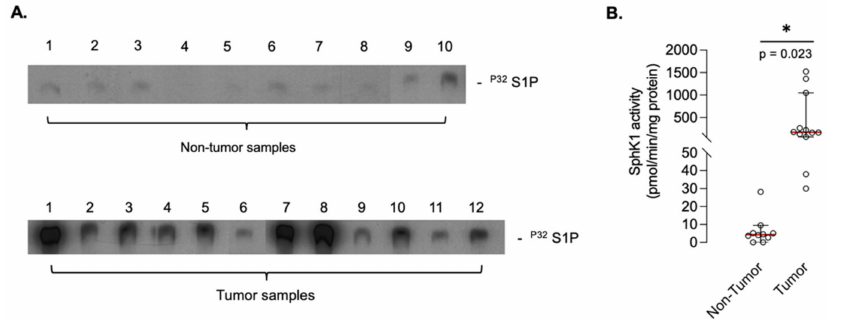
Figure 2. SphK1 activity in human osteosarcoma biopsy samples. ( A ), S1P content of 10 nontumoral and 12 tumoral biopsies as shown by thin-layer chromatography. ( B ), SphK1 enzymatic activity of biopsy samples expressed as pmol/min/mg of protein. Columns are individual SphK1 activity values and means with 95% CI. Mean SphK1 activities were 6.3 (95% CI: 0.45–12.1) and 432 (95% CI: 77.4–835) pmol/mg/min for nontumoral and tumoral biopsy samples, respectively. *, p < 0.01. The uncropped Thin-Layer Chromatography films have been shown in Figure